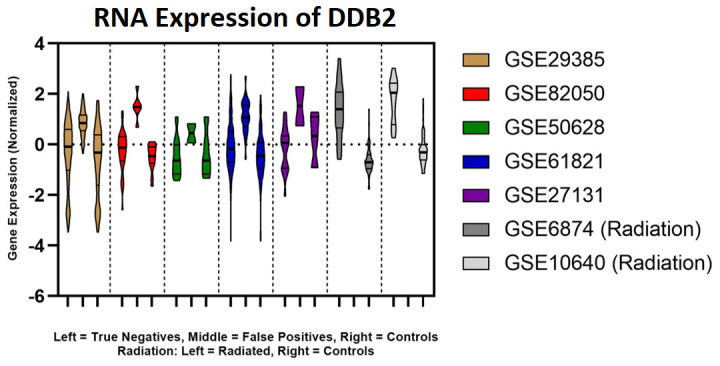
Violin Plots of
DDB2 Expression in Influenza- and Radiation-Exposed Patients.
DDB2 expression for Model 1 including Influenza patients, controls and radiation patients plotted using GraphPad. Each colour represents a different dataset. The left distribution of the radiation data (shaded grey) represents the expression of the radiated patients and the right distribution represents unirradiated controls. For all Influenza datasets (coloured), the left-most distribution represents the true negatives, the middle distribution represents the false positives, and the right-most distribution represents uninfected controls.